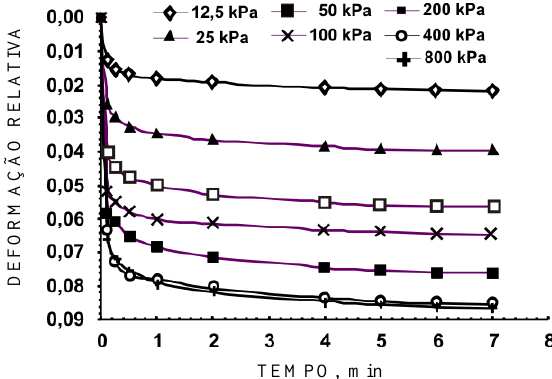
Figura 1. Deformação do solo, considerando o tempo de aplicação da pressão